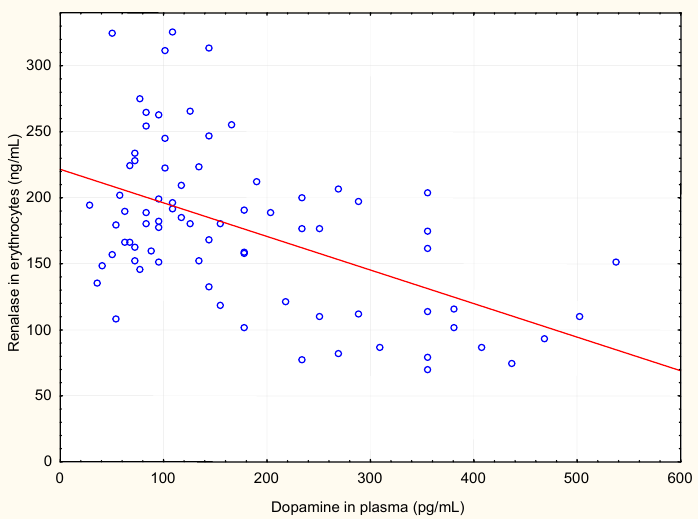
Figure 1. Correlation between concentrations of renalase in erythrocytes and dopamine in plasma of haemodialysis patients.